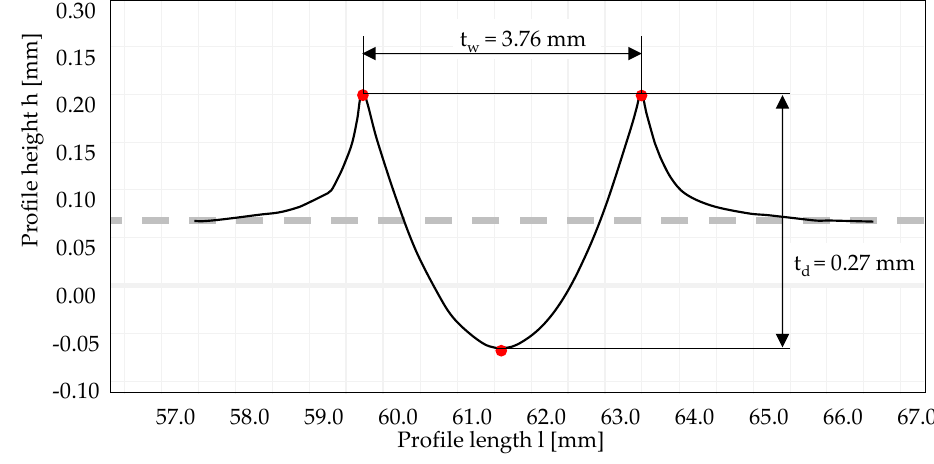
Figure 2. Characterization of the track geometry.